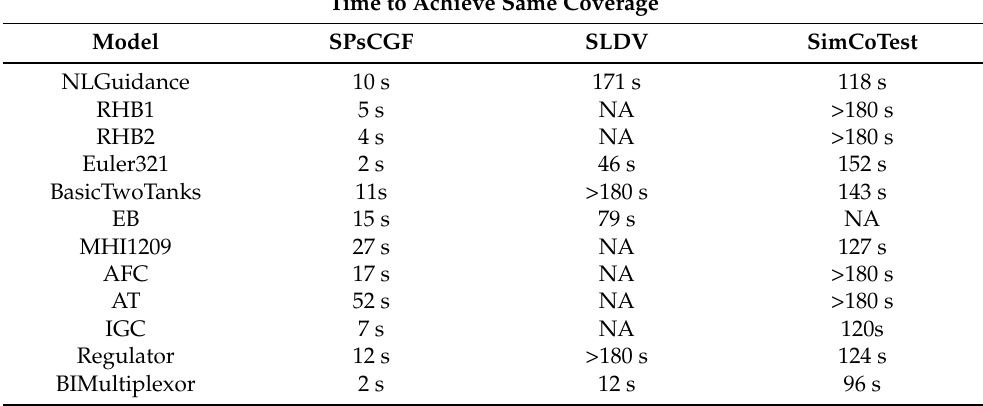
Table 2. Time Efficiency.